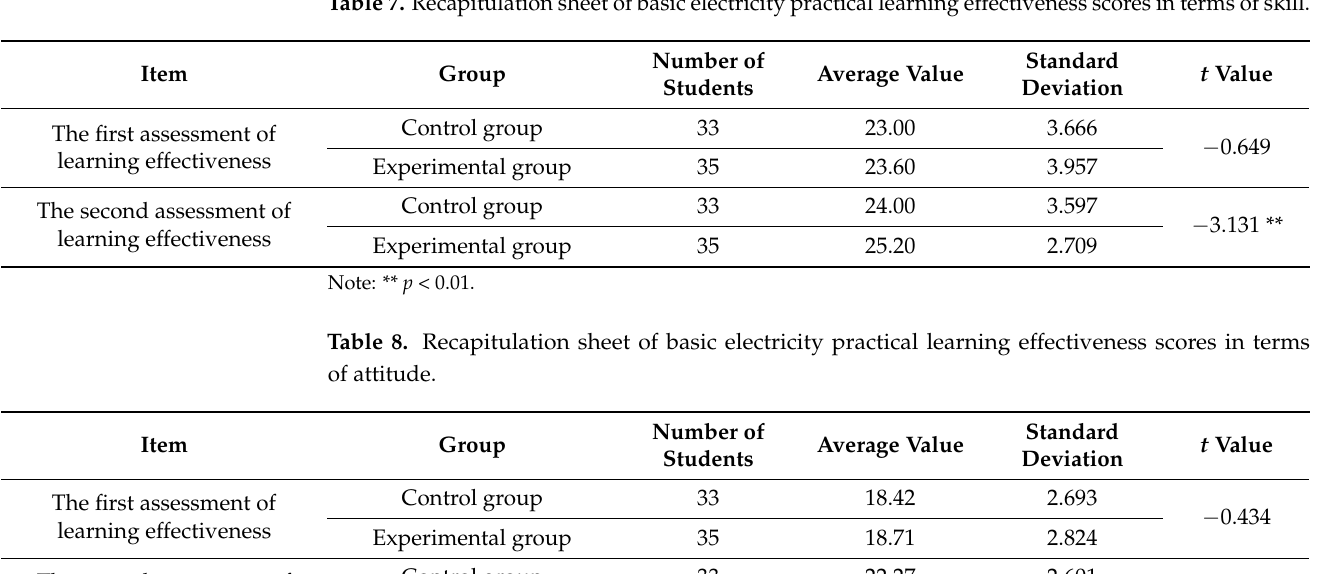
Table 7. Recapitulation sheet of basic electricity practical learning effectiveness scores in terms of skill.